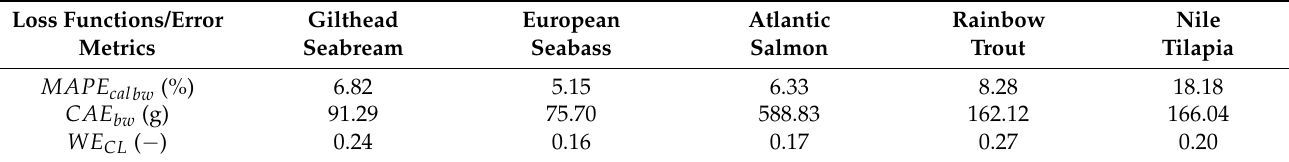
Table 2. Error metrics for the calibration data set for each